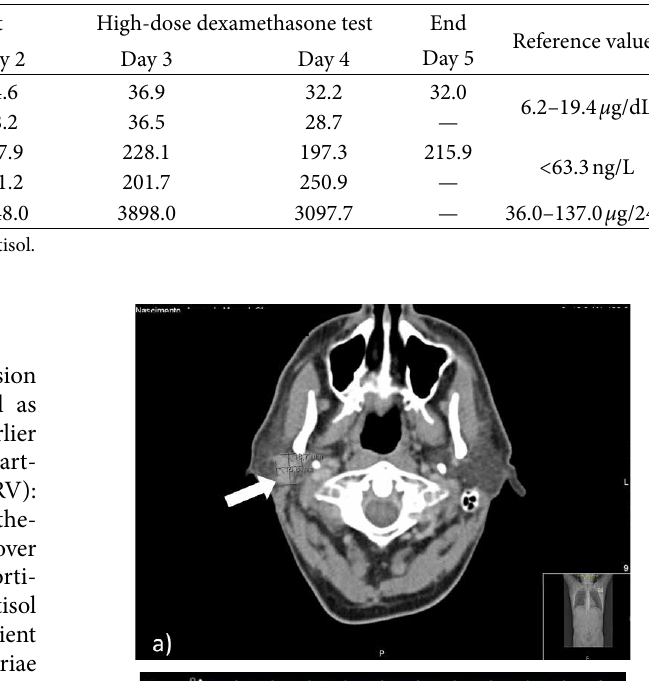
Table 2: Low- and high-dose dexamethasone suppression tests.